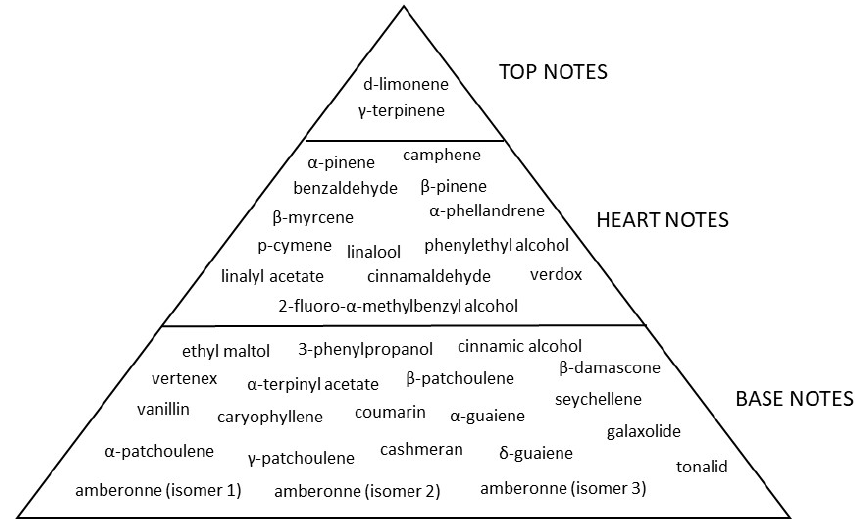
Figure 4. Olfactory pyramid of “ Narguilé ” pure fragrance.